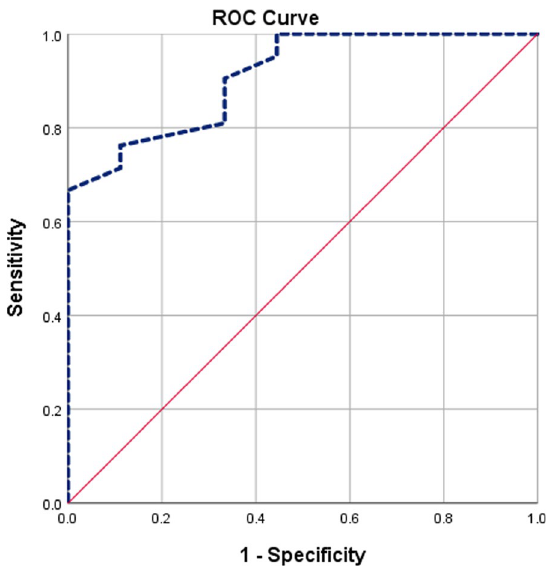
Fig. 2 ROC curve plotted for diagnosis of peritoneal carcinomatosis based on SUVmax